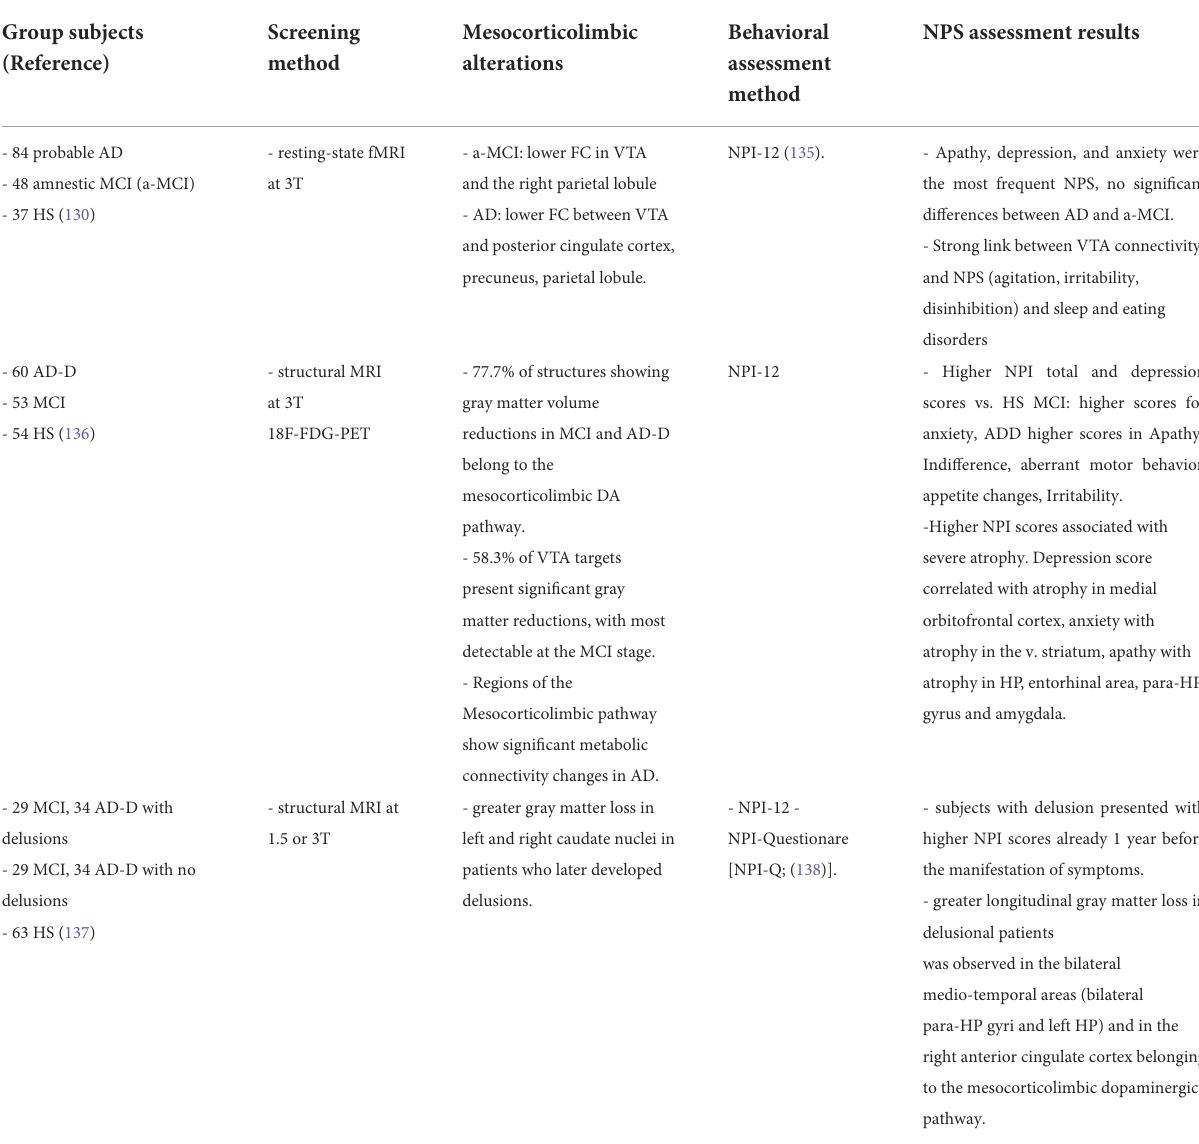
TABLE 1 Summary of clinical studies investigating direct evidence for an association between deficits in the mesocorticolimbic dopamine system and